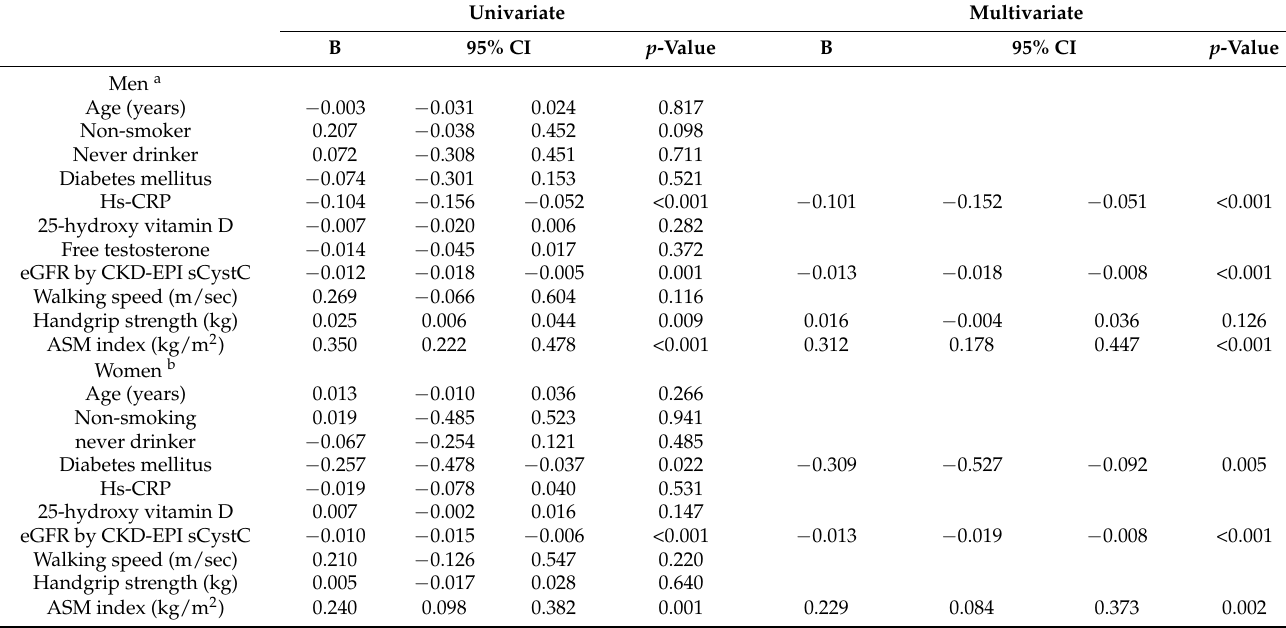
Table 2. Simple and multiple linear regression analyses for serum myostatin level in 519 men and 534 women.